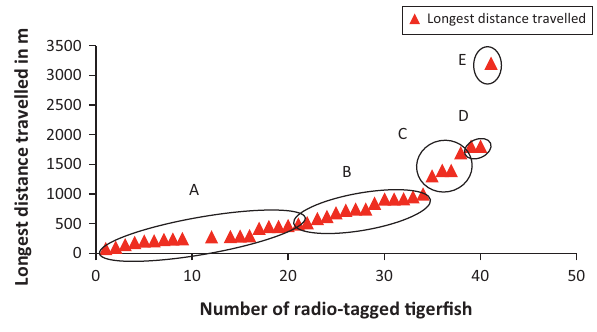
FIGURE 5: Clustering of longest distance travelled of radio-tagged tigerfish for the period January–December 2003. A, 0 m–500 m; B, 501 m–1000 m;